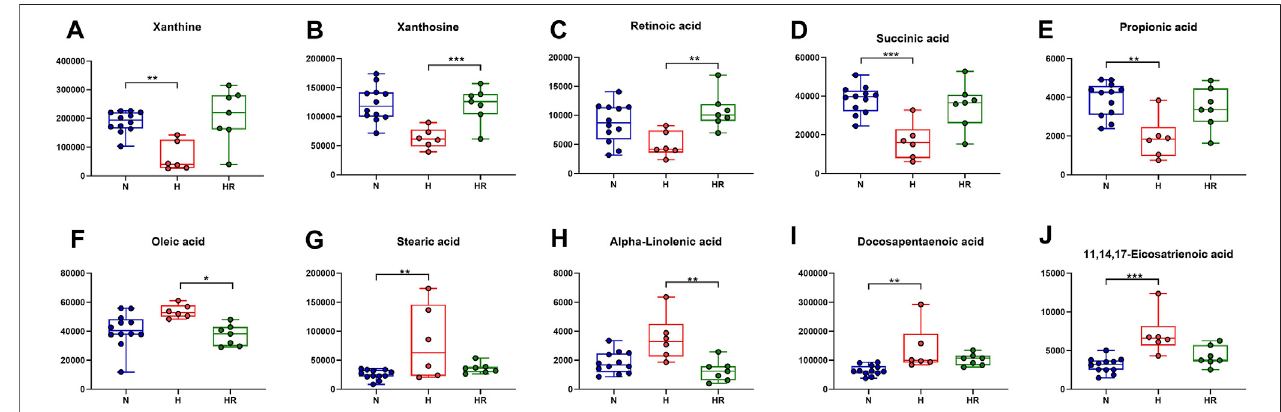
FIGURE 7 | Effects of REV on potential biomarkers for liver metabolites. (A – E) Expression of xanthine (A) , xanthosine (B) , retinoic acid (C) , succinic acid (D) , and propionic acid (E) . (F – J) Expression of oleic acid (F) , stearic acid (G) , alpha-linolenic acid (H) , docosapentaenoic acid (I) , 11,14,17-eicosatrienoic acid (J) . N, normal group, n (cid:2) 8; H, high-fat diet group, n (cid:2) 10; and HR, high-fat diet plus REV treatment group n (cid:2) 7. All data are mean ± SEM. * p < 0.05 N vs. H group; # p < 0.05 HR vs. H group, two-tailed Mann – Whitney U